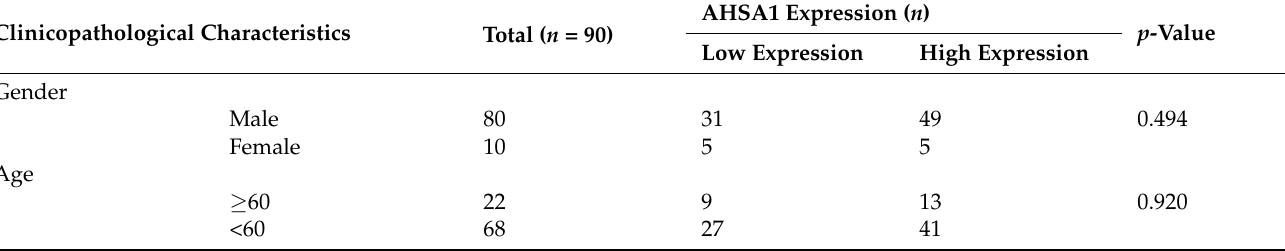
Table 3. Correlation between AHSA1 expression in tumor tissues and clinicopathological characteris- tics of patients in HCC